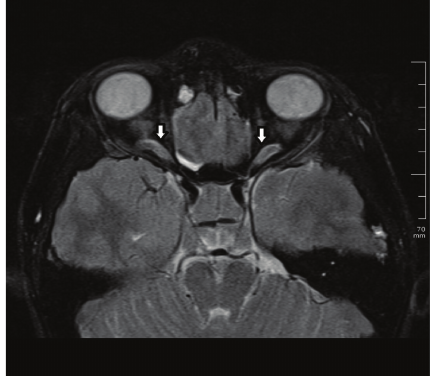
Figure 3: Magnetic resonance imaging. Contrast-enhanced axial T2-weighted MRI scan shows cerebrospinal fluid tracking along the optic nerve sheath.